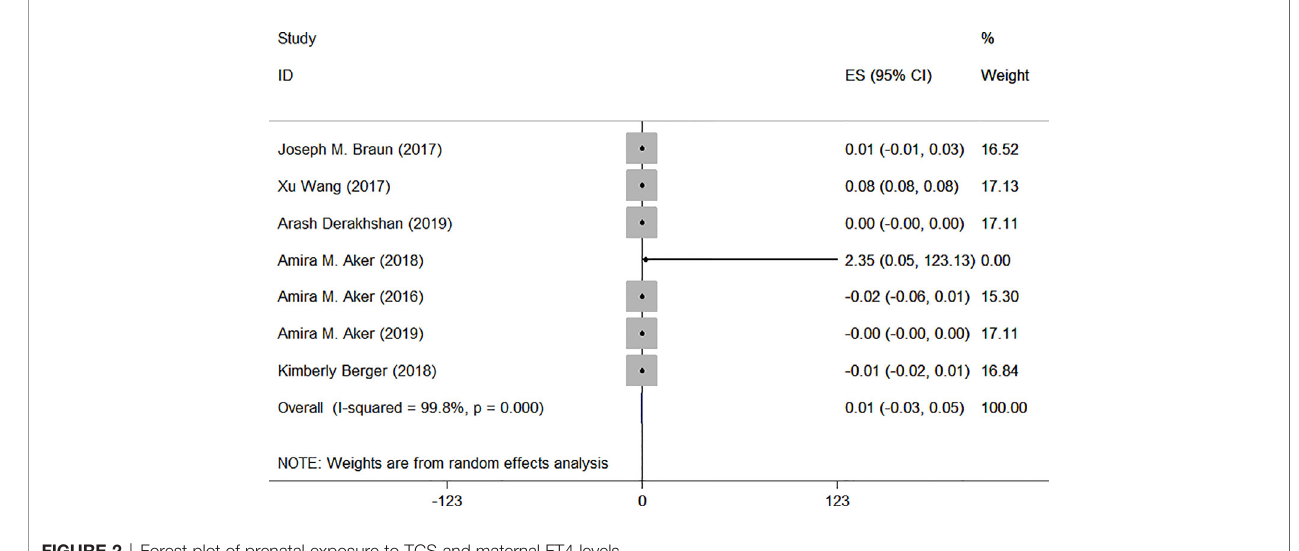
FIGURE 2 | Forest plot of prenatal exposure to TCS and maternal FT4